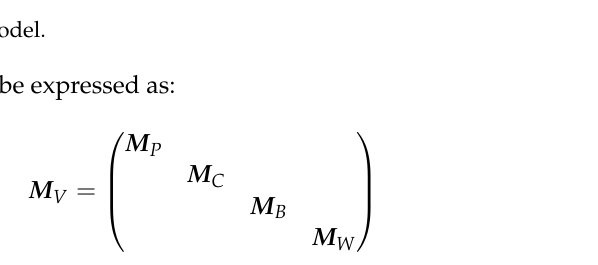
Figure 4. Vehicle dynamic model.